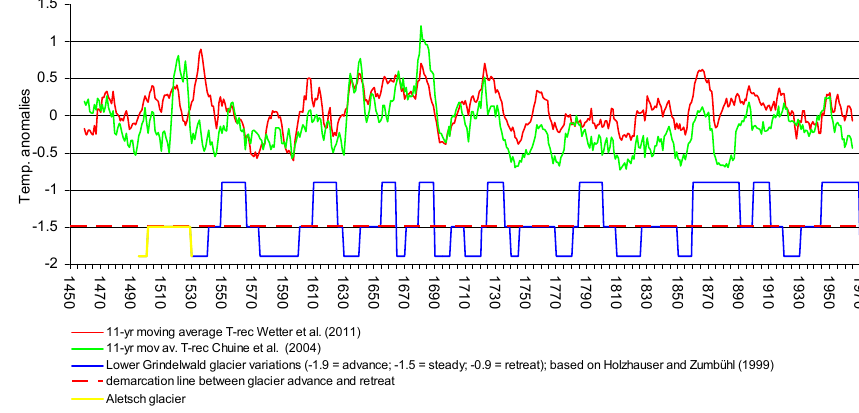
Lower Grindelwald glacier variations (-1.9 = advance; -1.5 = steady; -0.9 = retreat); based on Holzhauser and Zumbühl (1999) demarcation line between glacier advance and retreat Aletsch glacier Fig. 11. Comparison between glacier fluctuations and reconstructed temperature anomalies by Basel WGHD- and Burgundy GHD series; 11 yr moving averages.